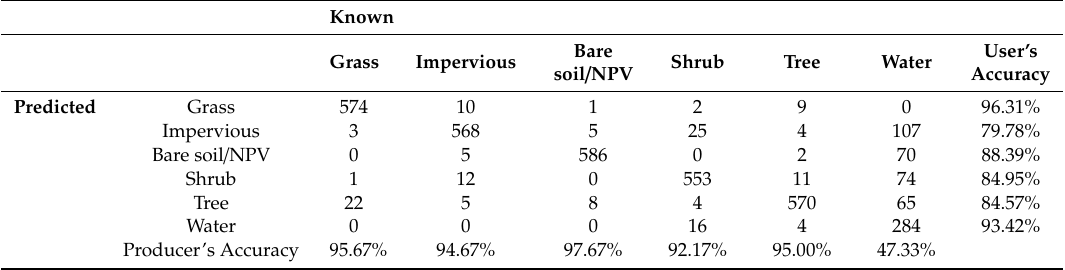
Table 2. Confusion matrix for Sentinel-2 only classification with overall accuracy of 87% and weighted overall accuracy of 90%.